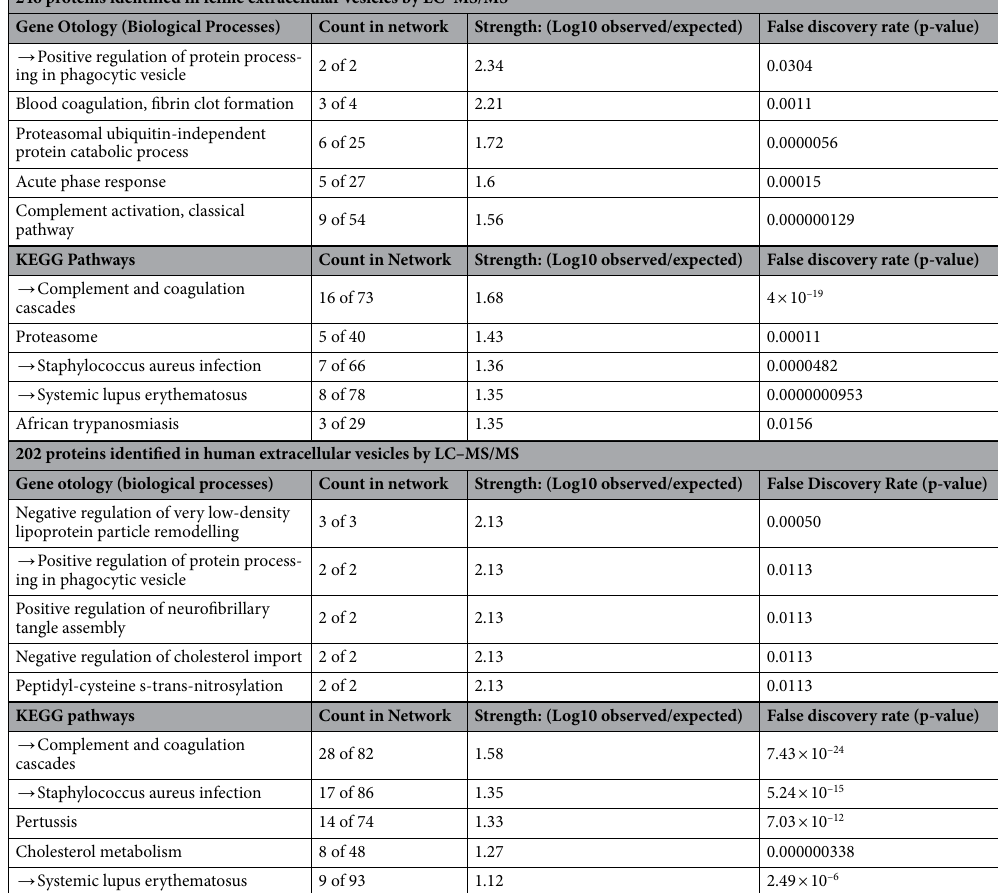
Table 1. Functional classification of proteins identified by LC–MS/MS. When the top 5 biological processes (Gene Otology) and KEGG pathways associated with human and feline protein IDs were compared, both humans and felines showed an enrichment in proteins associated with one similar biological process and three common KEGG pathways (indicated by → ) 24,25 . Count in Network indicates the number of proteins in the network associated with a particular term. Strength measures how large the enrichment effect is (Observed = the number of proteins present in the network that are annotated with a specific term, expected = the number of proteins we expect to be annotated with this term in a random network of the same size). False Discovery Rate measures the significance of the enrichment. P-values shown have been corrected for multiple testing within each category using the Benjamini–Hochberg